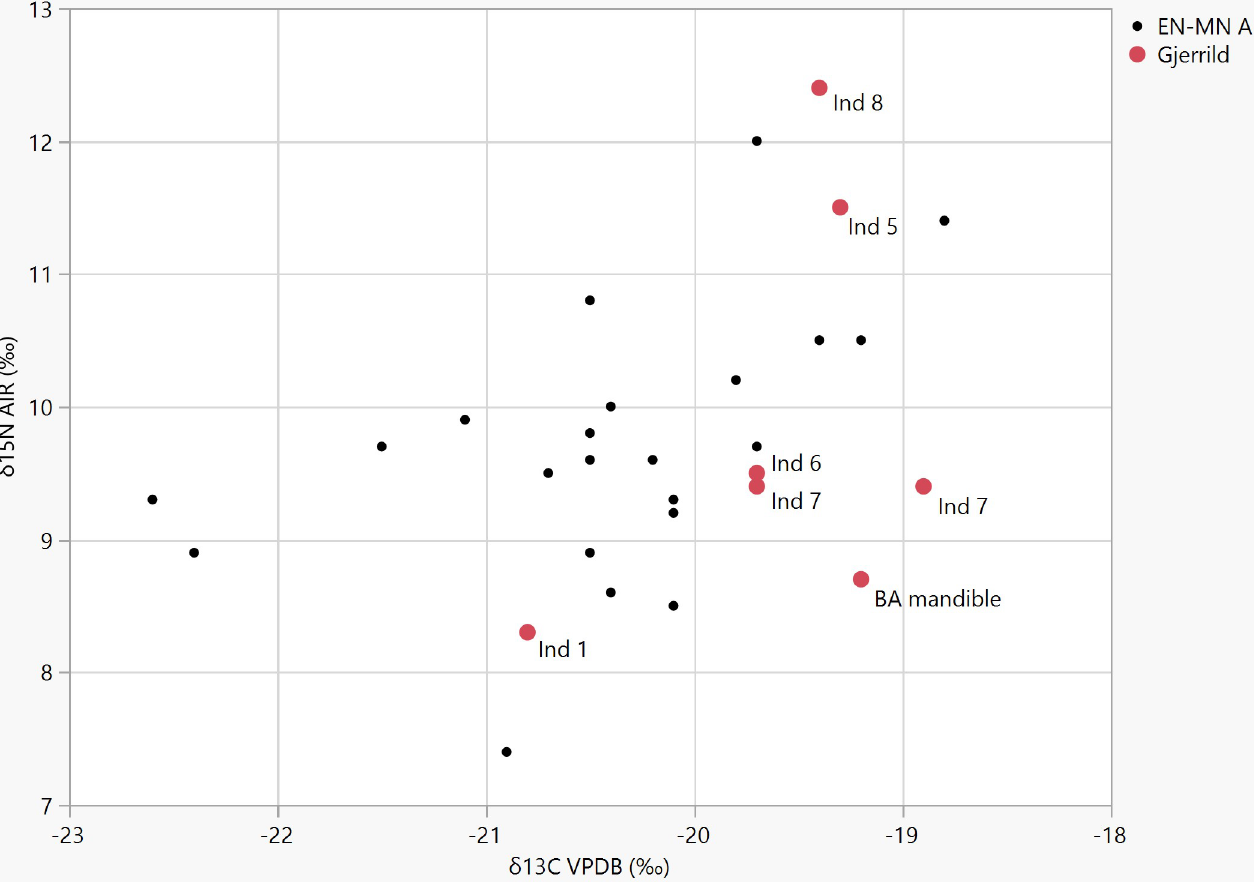
Fig 2. Isotope measurements. δ 13 C and δ 15 N values from Gjerrild compared to values from other Early (EN) and Middle (MN A) Neolithic Danish individuals attributed to the TRB culture (data from Fischer et al. 2007 [69]). Numbers denote the different skeletons from Gjerrild. Individuals 5 and 8 are children (Inf